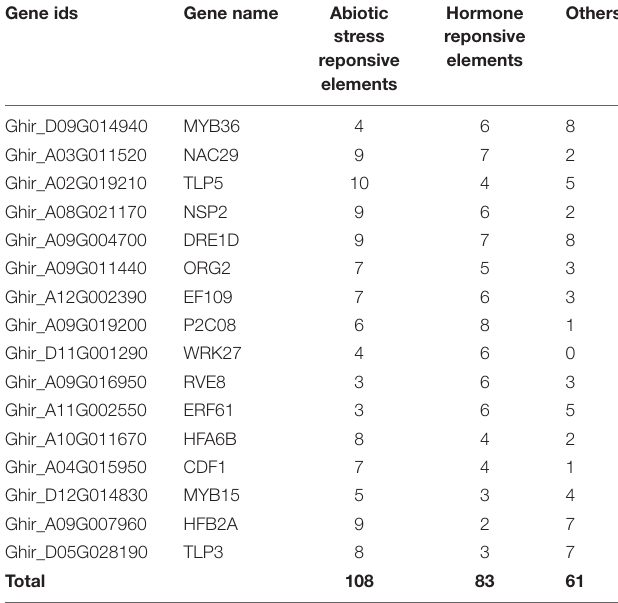
TABLE 3A | Cis -regulatory elements of identified hub genes in (A) drought and (B) salt stress condition. Cis -regulatory elements of identified hub genes in drought stress